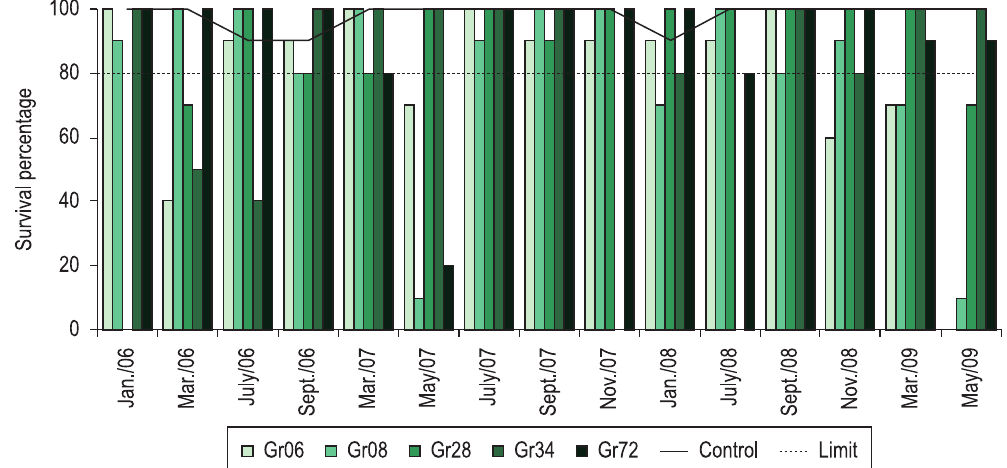
Figure 2. Survival of Daphnia magna exposed to Gravataí River sediment samples, control group and expected survival from January/2006 to